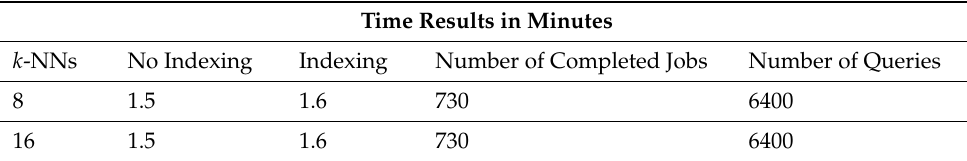
Figure 6. Time Cost for k -Anonymity Set Computation with or without Indexing for 3 Cases of Total Input Data in Executor. Table 7. Time for 80 Mobile Objects without Indexing and with R -Tree Indexing.